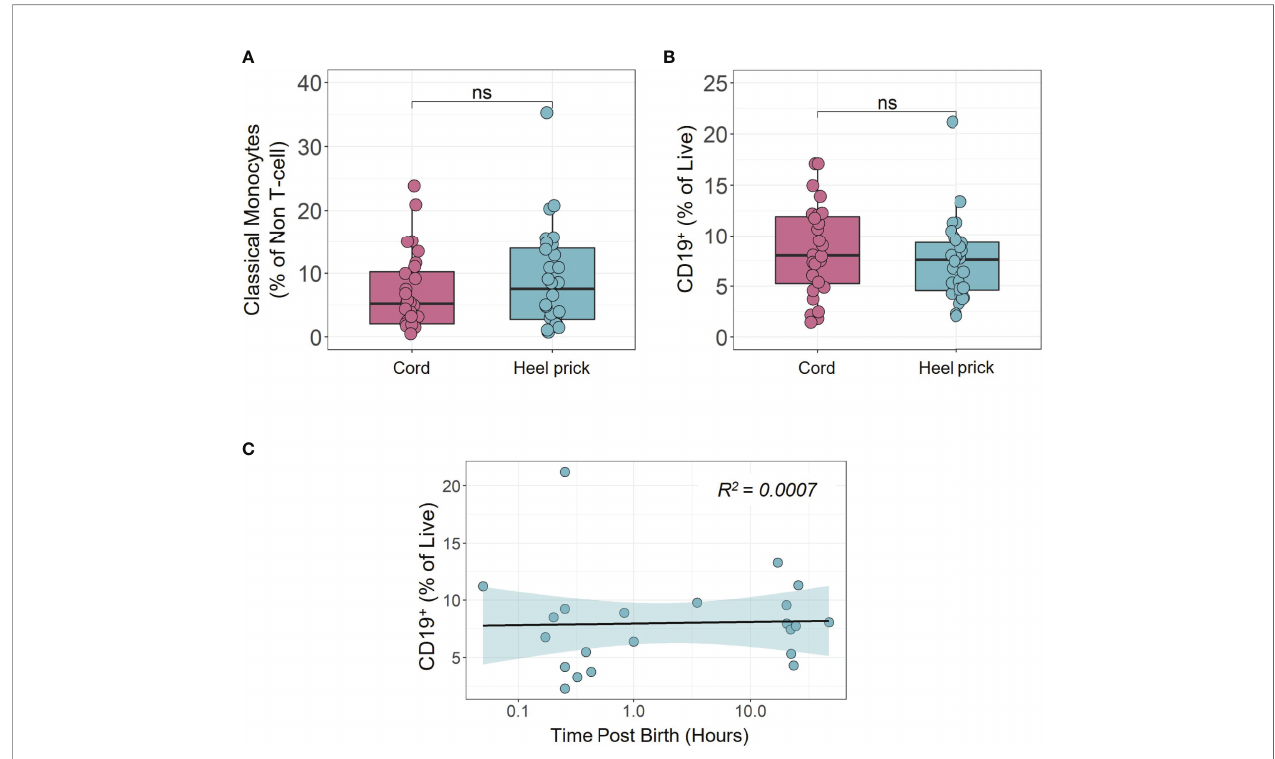
FIGURE 3 | Percentage of neonatal classical monocytes and B cells remain unchanged immediately post birth. Proportion of (A) classical monocytes (CMCs) and (B) CD19 + B cells was measured by multiparametric fl ow cytometry in unstimulated paired cord blood and heel prick samples (n=28) stained immediately post thawing (n=28). (C) Time dependent linear regression analysis of unstimulated CD19 + B cells from heel prick blood samples collected within 48 h post birth (n=28). Box and whisker plots follow standard Tukey representations and indicate the median (central line), the interquartile range (upper line = 75 th percentile, lower line = 25 th percentile), and the whiskers represent 1.5 x 75 th /25 th percentile. NS, non-signi fi cant for all paired data between cord and heel prick samples were assessed using two-sided paired Wilcoxon tests. ns, non-signi fi